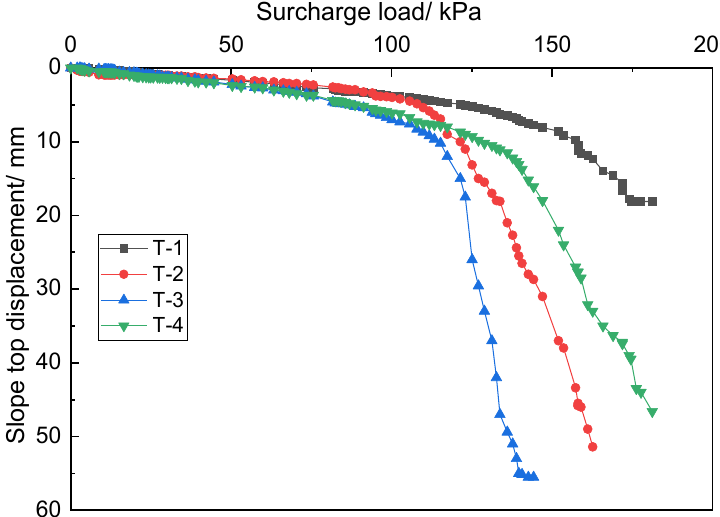
Figure 2. Variation of vertical displacement on the top of slope with the applied load.